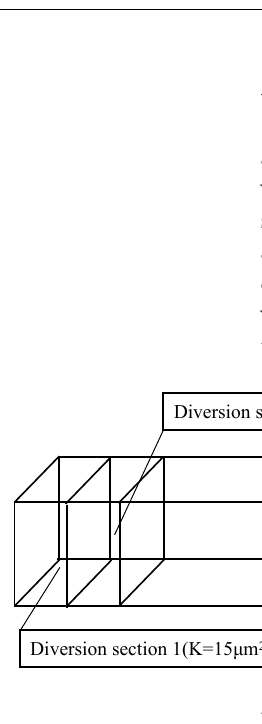
Figure 1. Three-section core with diversion section.